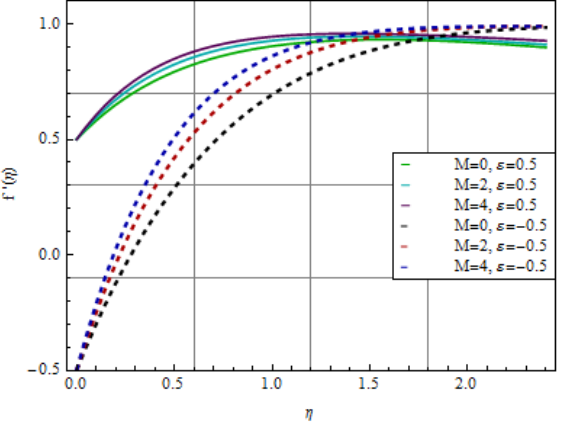
Fig. 11: The velocity distribution for alumina-sodium alginate nanofluid for different values of unsteadiness and velocity ratio